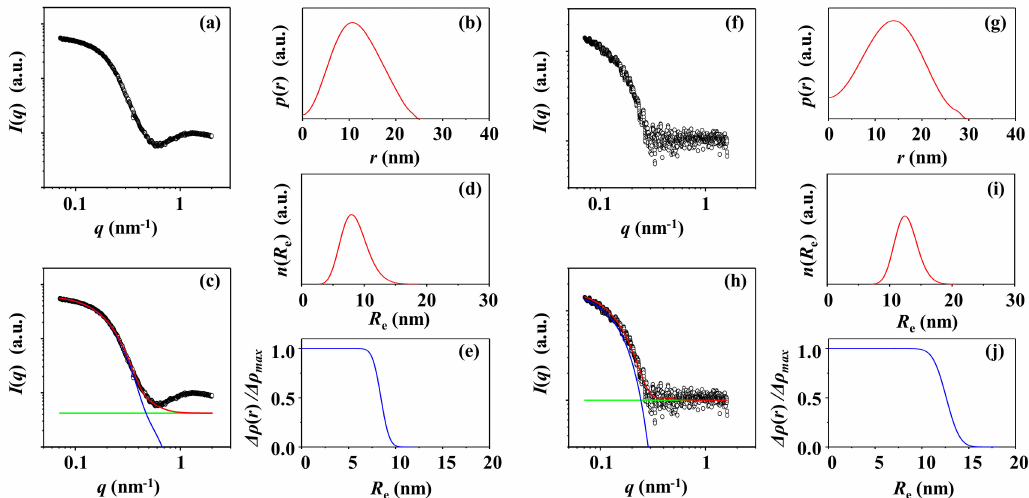
Figure 6. X-ray scattering data analysis of PS-4 particle. ( a ) SAXS profile measured at room temperature and corrected for water as the solution medium: ( b ) pair distance distribution functions p ( r ) obtained from the scattering profile using the IFT method; ( c ) data analysis results; ( d ) radius distribution obtained by the data analysis in ( c ); ( e ) density distribution obtained by the data analysis in ( c ). ( f ) SAXS profile measured at room temperature and corrected for the supernatant as a solution medium: ( g ) pair distance distribution functions p ( r ) obtained from the scattering profile using the IFT method; ( h ) data analysis results; ( i ) radius distribution obtained by the data analysis in ( h ); ( j ) density distribution obtained by the data analysis in ( h ). ( c , h ) the open symbols are the measured data and the red solid line represents the sum of the profiles obtained by fitting the data using two-phase ellipsoid model (blue line) and local random two-phase contributions (purple line) and the background (green